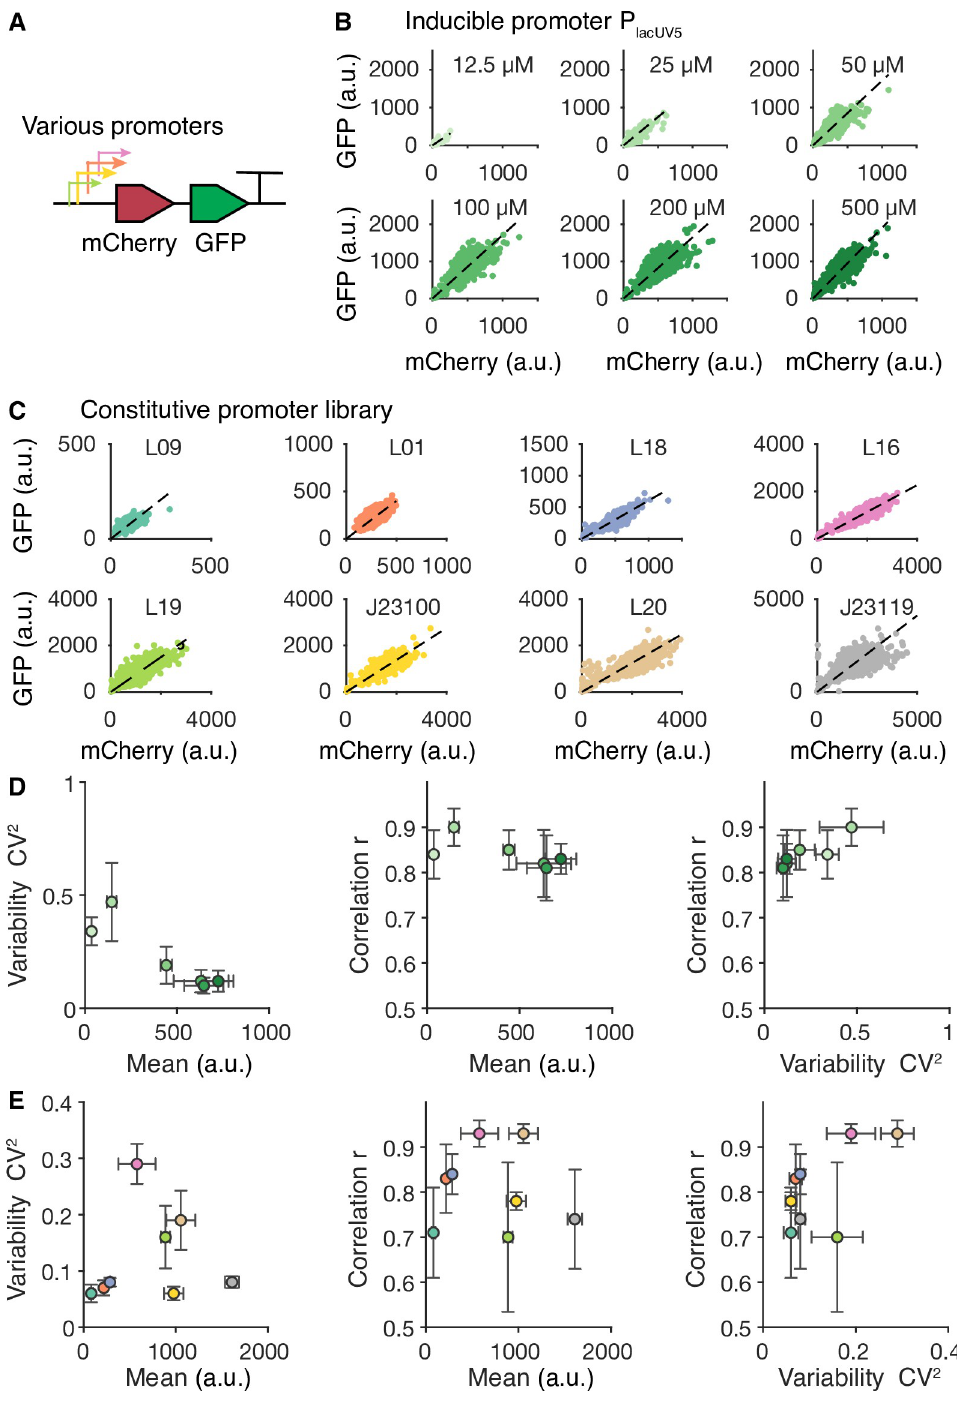
Fig 4. Polycistronic operon enables highly correlated protein expression. (A) Various promoters are used to control the co-expression of mCherry and GFP from a polycistronic operon. (B) mCherry and GFP in individual cells under the control of the inducible promoter P lacUV5 at different IPTG induction levels. a.u., arbitrary units. (C) mCherry and GFP in individual cells under the control of constitutive promoters with different strengths. (D) Relationships among variability, mean, and correlation between mCherry and GFP in the inducible promoter construct. (E) Relationships among variability, mean, and correlation between mCherry and GFP in promoter library constructs. Variability and mean are quantified using